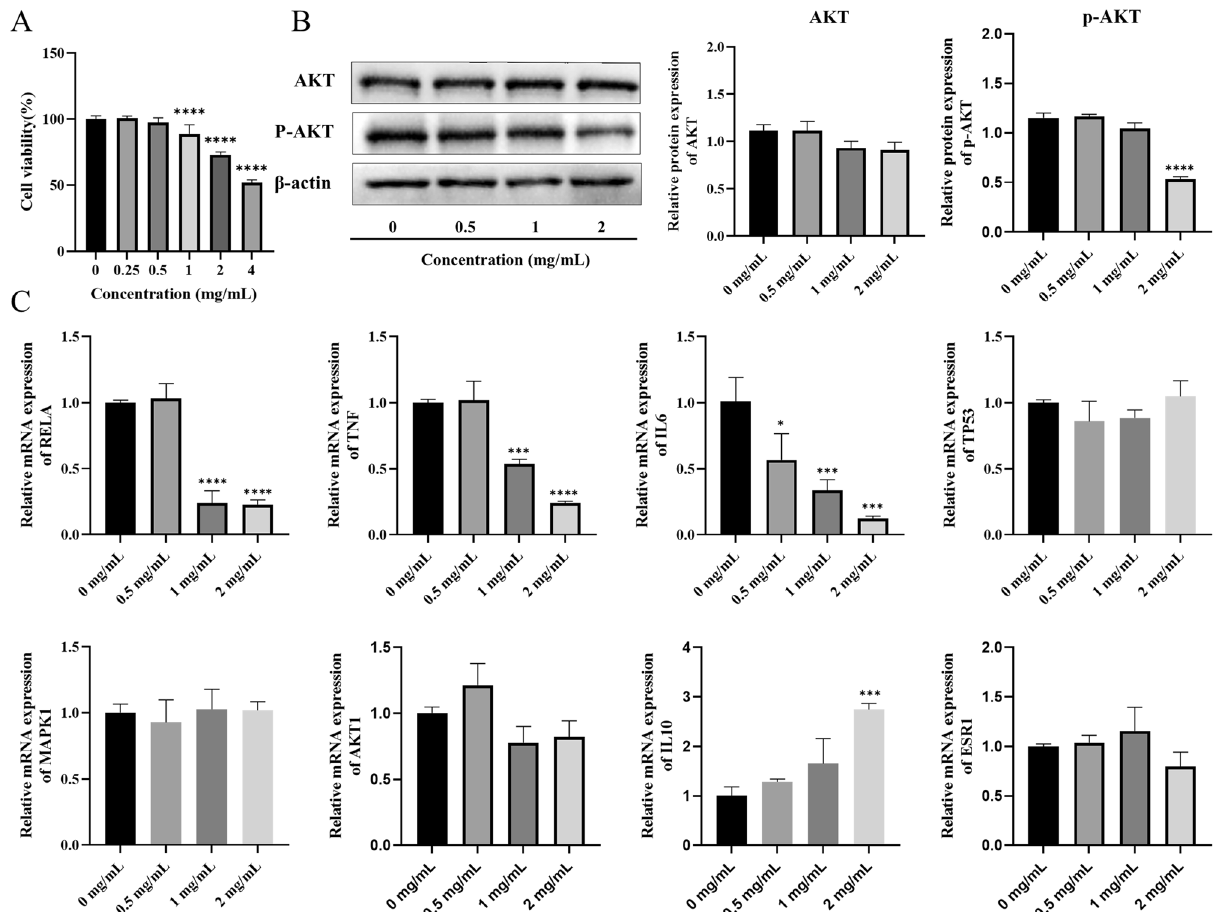
Figure 7. Cell experiments validate results of network pharmacology. ( A ) CCK8 assays of different HDW concentrations (0, 0.5, 1, 2 mg/mL) incubated MH7A cells for 48 h. ( B ) The expression levels of AKT and p-AKT were measured using western blotting. Original blots are presented in Supplementary Fig. 2. ( C ) The effect of HDW on the mRNA levels of RELA in MH7A cells. Compared with control (0 mg/mL), * P < 0.05,